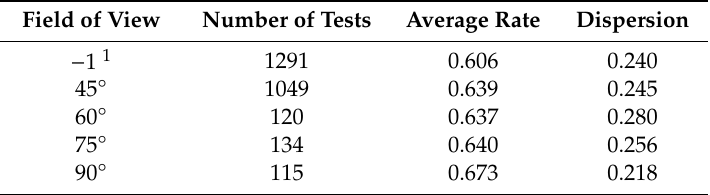
Table A2. Numerical results of the users regarding the camera field of view.